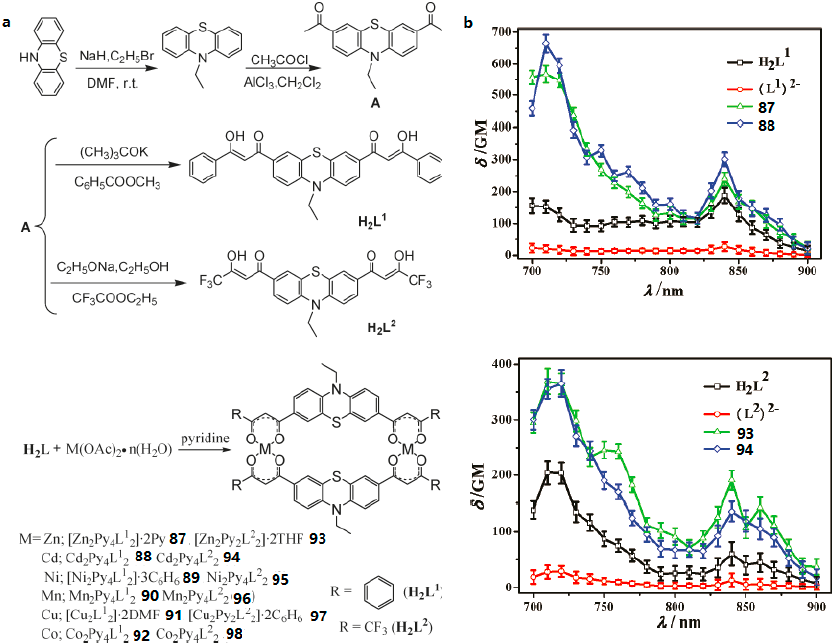
Figure 24. ( a ) Synthesis of two bis- β -diketones H 2 L 1 , H 2 L 2 and their complexes 87 – 98 ; ( b ) 2PA spectra of all the compounds ( c = 0.1 mM) in THF.